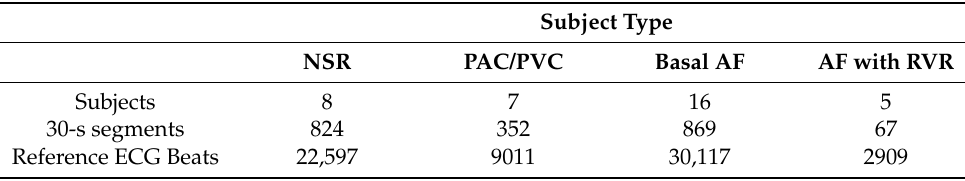
Table 1. Independent Testing Dataset